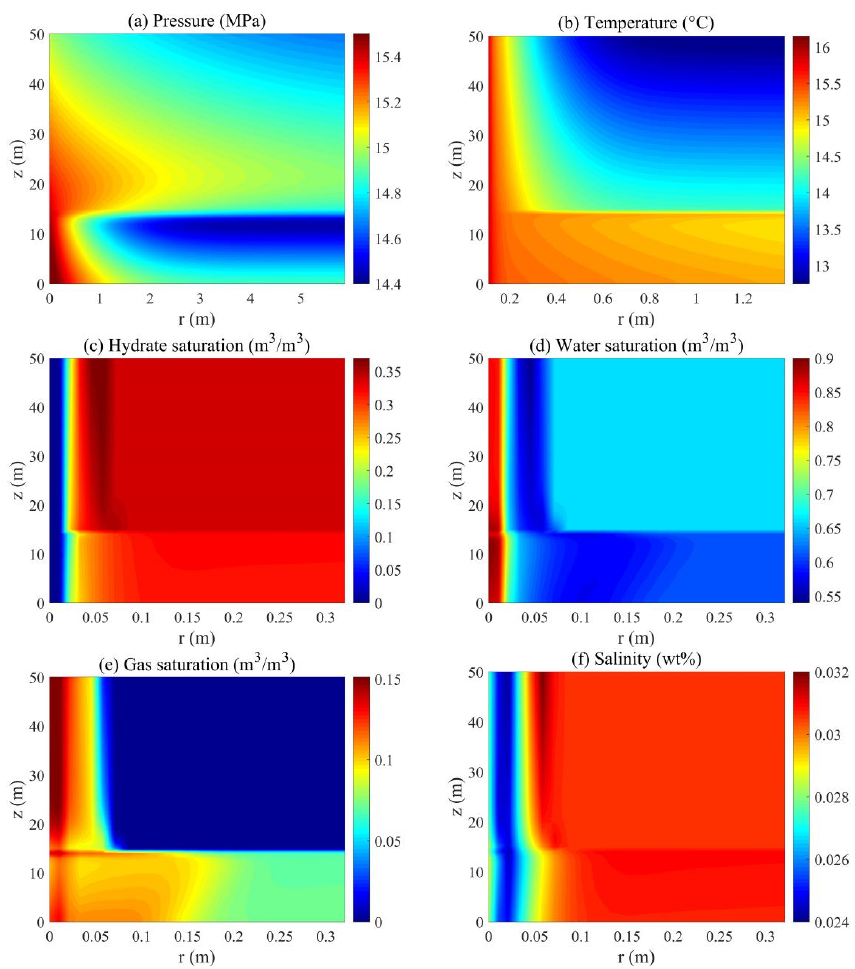
Figure 5. Two-dimensional physical distribution of the hydrate reservoir at the 24th hour of the invasion process of drilling fluid. ( a ) Pressure distribution; ( b ) temperature distribution; ( c ) hydrate saturation distribution; ( d ) water saturation distribution; ( e ) gas saturation distribution; ( f ) salinity distribution.